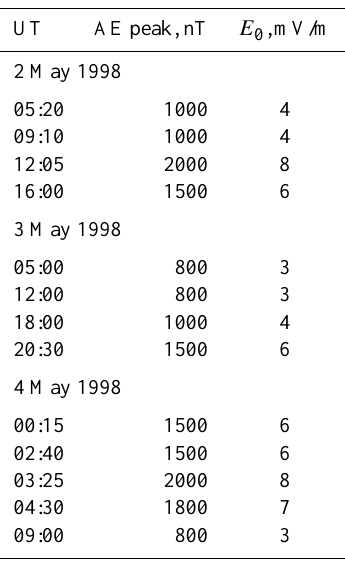
Table 1. Times and magnitudes of E 0 of the launched pulses at substorm onset times together with AE values during the period of 2–4 May 1998.